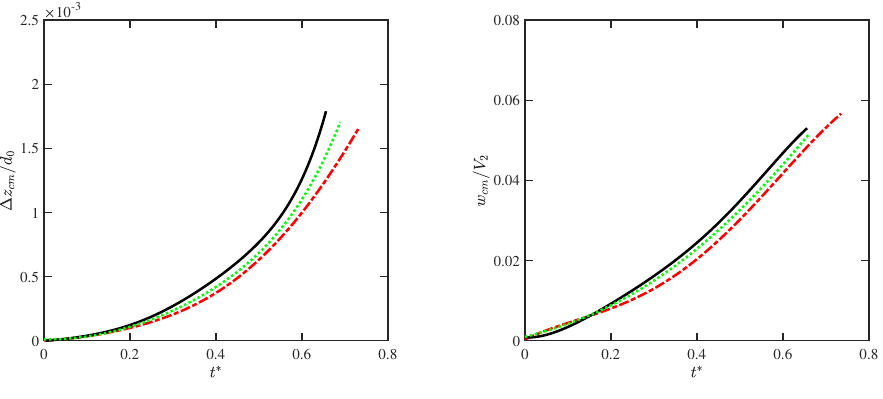
Figure 6. Time history of the normalized CM drift ( left ) and velocity ( right ) of the droplet: present solutions CFD II (black solid line) and CFD III (green dotted line), compared to reference numerical solutions (red dashed line).